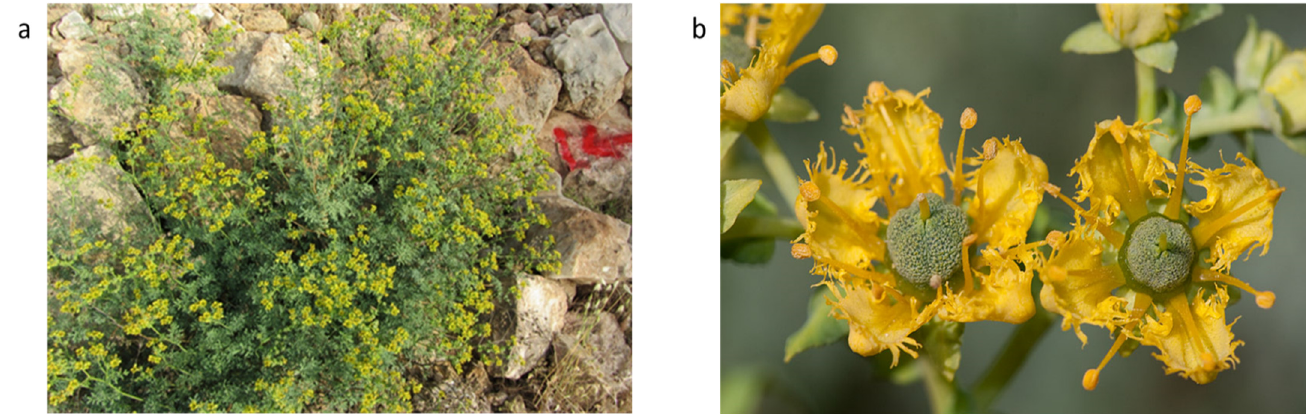
Figure 1. ( a ) Ruta chalepensis plant in the wild; ( b ) Ruta chalepensis flowers: the left flower is pentam- erous (usually a single flower per inflorescence), while the right flower is tetramerous. Table 1. Site name, province, habitat description, rainfall (in mm), altitude (m), latitude (N) and longitude (E) of the Ruta chalepensis populations collected from northern Jordan.